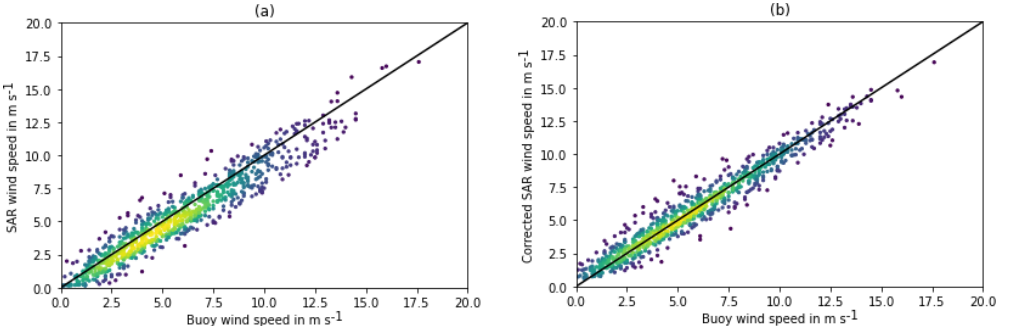
Figure 5. Scatter plots between SAR and buoy wind speeds at 4ma . s . l . before machine learning (a) and after machine learning (b) using the test dataset. The colours represent the density of points, and the black curve is the identity line.